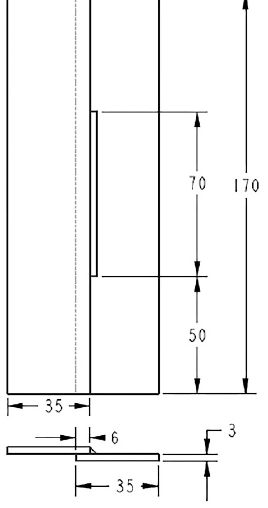
Figure 2. Dimensional model of lap joint.